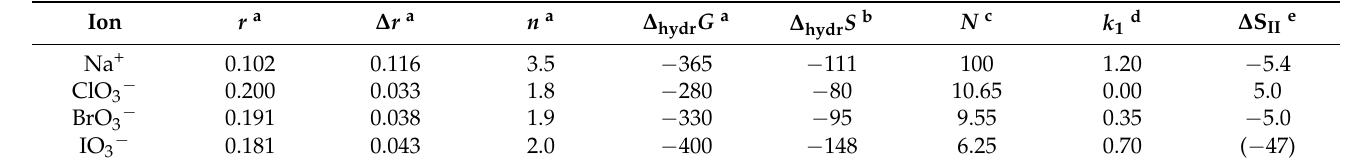
Table 5. Anion radius ( r , in nm), hydration shell thickness ( ∆ r , in nm), and number of water molecules in the hydration shell (n). Free energy change ( ∆ hydr G ) and entropy change ( ∆ hydr S ) of hydration, lyotropic number ( N ), molar surface tension increment ( k 1 ) and entropy change of water ( ∆ S II